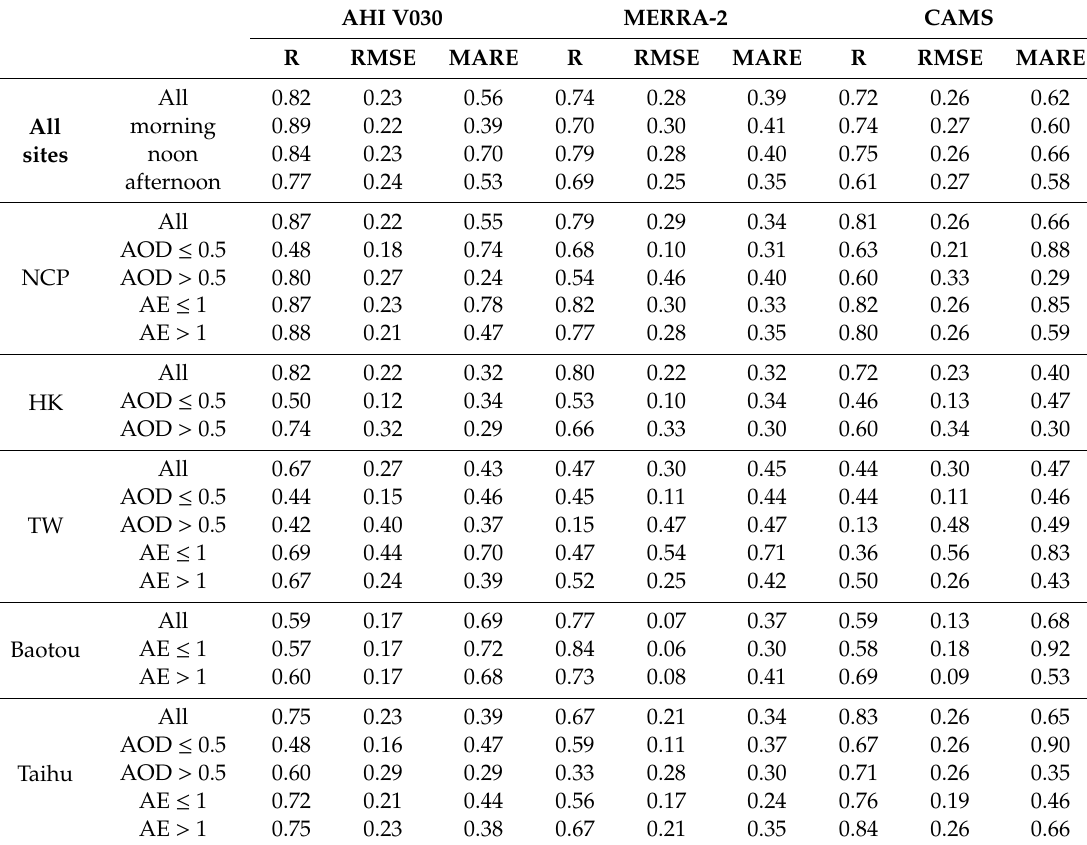
Table 2. Validation statistics of AOD products under di ff erent